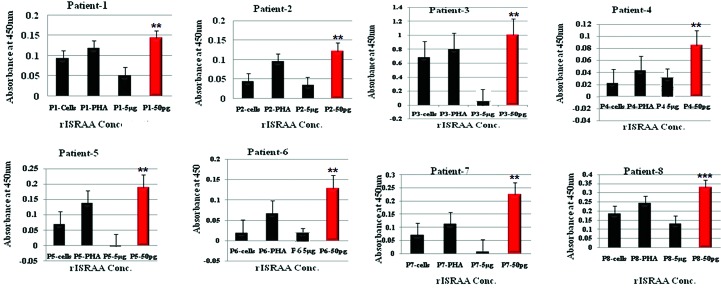
Effect of ISRAA on immunosuppressed cells. This figure illustrates the effects of 5 μg and 50 pg of ISRAA on patient’s PBMCs in terms of cell proliferation measured by an MTT assay. Note significant proliferative effects in all patients with 50 pg of rISRAA (**P<0.005, ***P<0.0005). PHA did not reveal significant proliferative effects compared with non-stimulated cells. rISRAA, recombinant immune system-released activating agent; PBMCs, peripheral blood mononuclear cells; PHA, phytohemagglutinin; Conc, concentration.